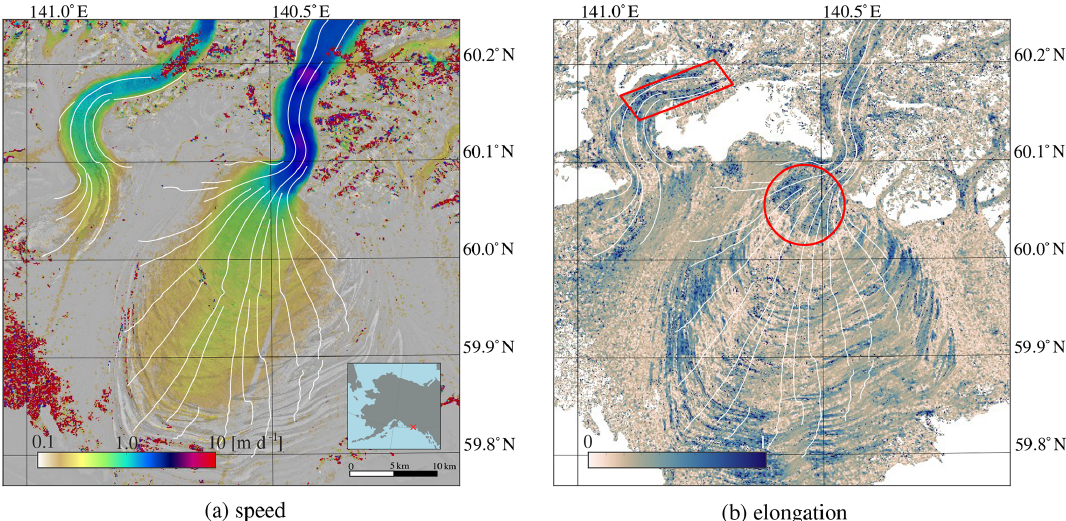
Figure 5. Image displacement (a) and elongation of the correlation ridge (b) . The red parallelogram illustrates large values of correlation spread, which also aligns with shear flow as in Fig. 6a, while the large spread highlighted by the red circle is probably due to crevassing, since flow is fairly homogenous in this